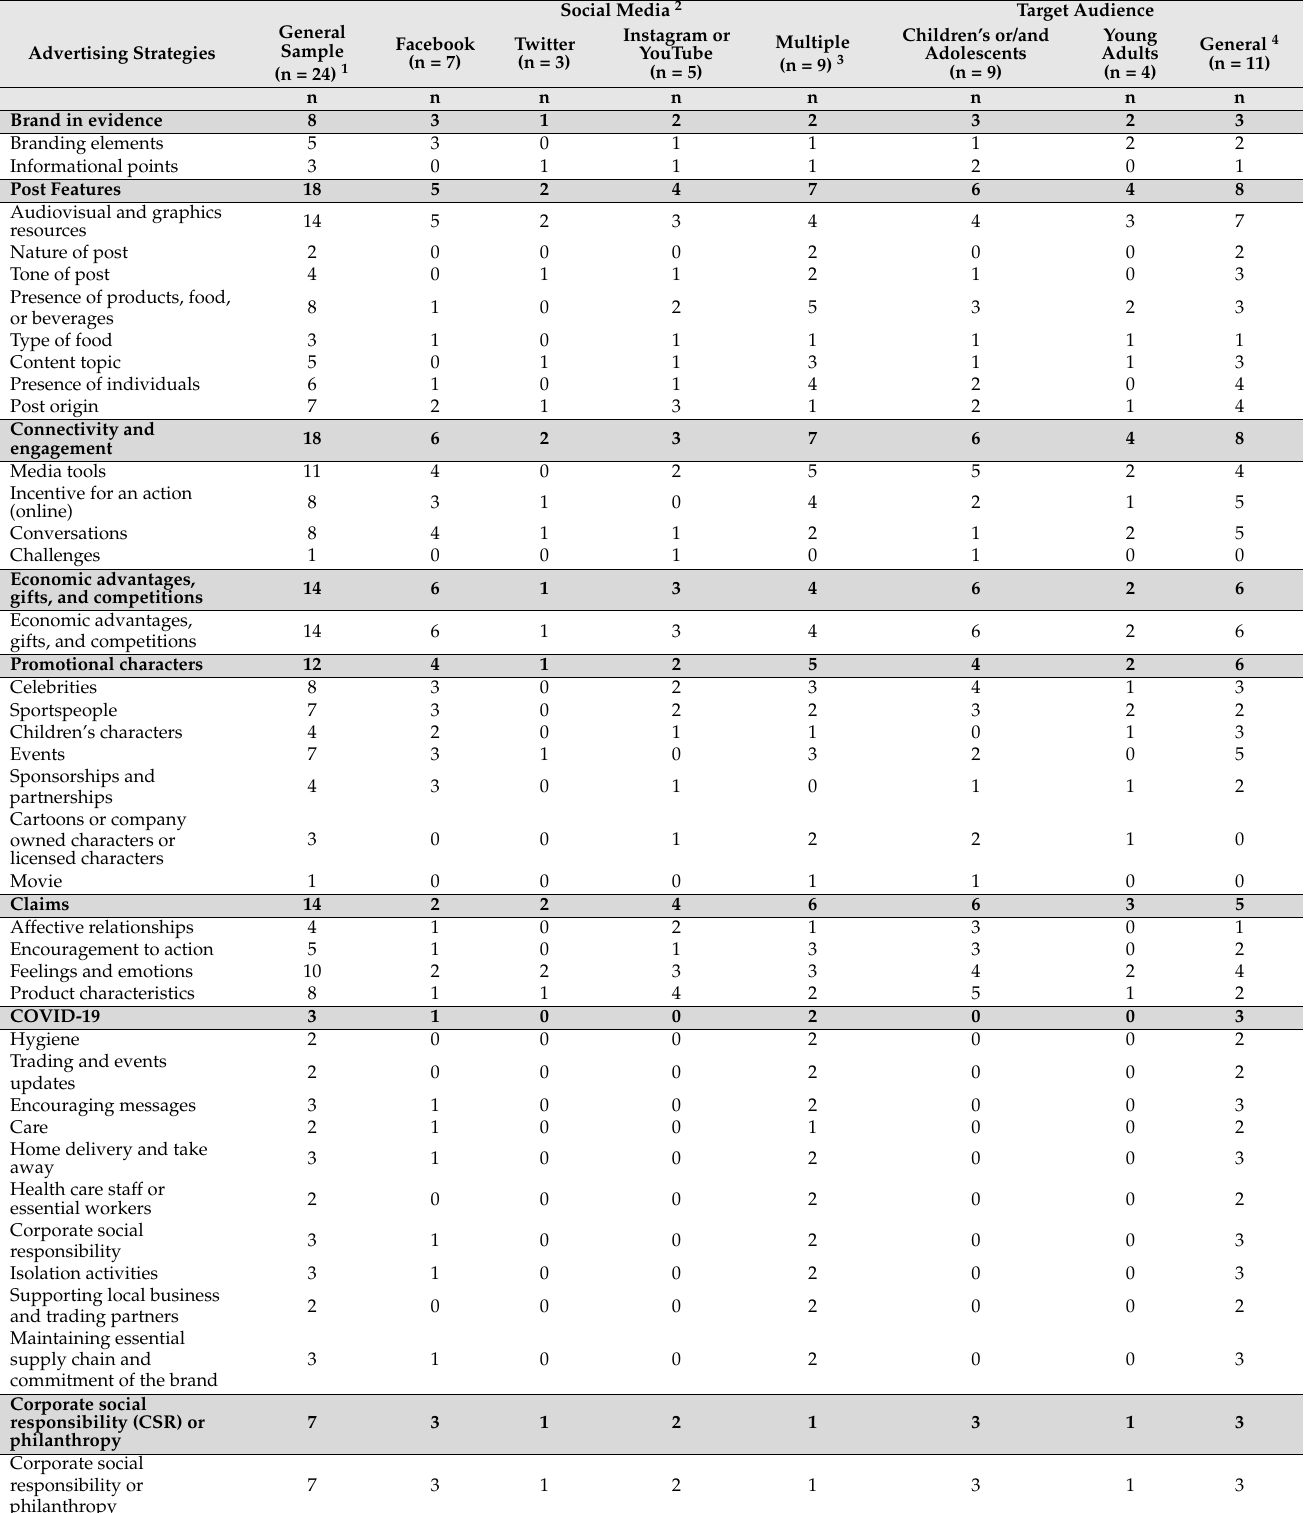
Table 4. Advertising strategies in general sample and stratified by social media and the target